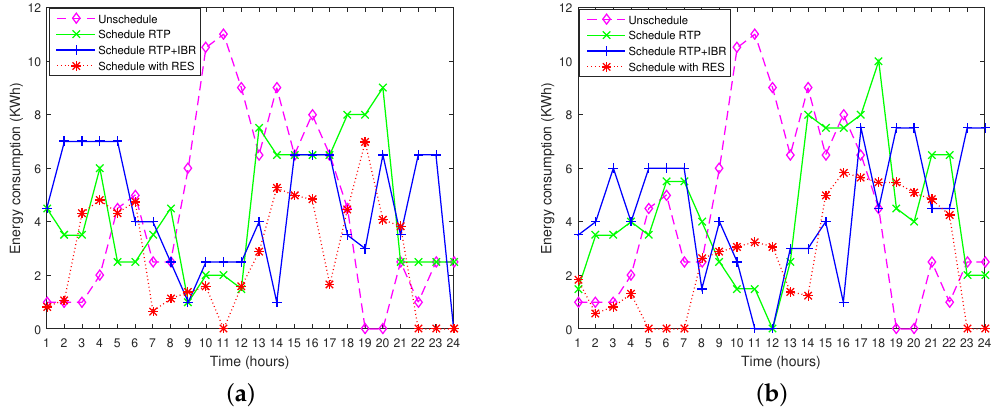
Figure 8. Unscheduled and scheduled load profiles against various cases; RTP, RTP+IBR and RES. ( a ) without control parameter; ( b ) with control parameter.